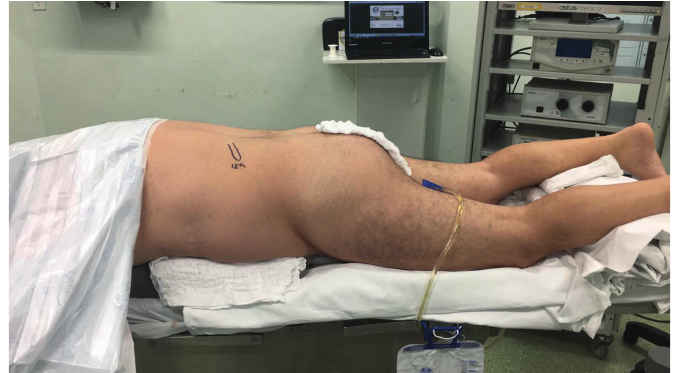
Figure 1 - ventral position.